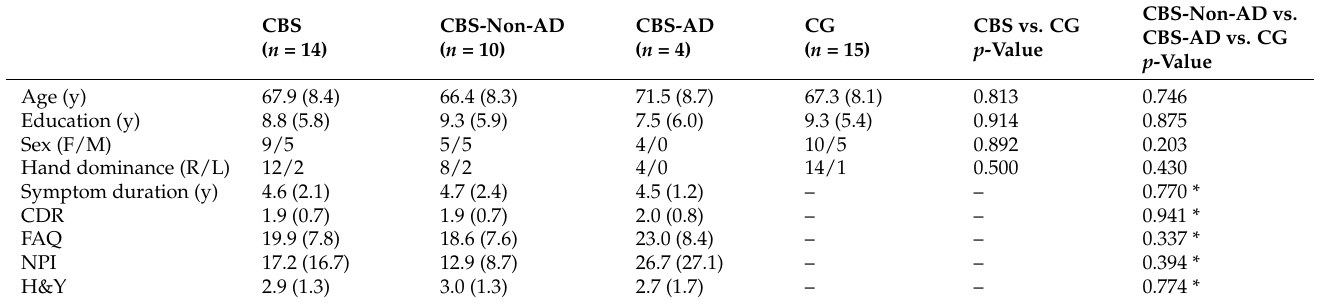
Table 2. Demographic and clinical characteristics of the